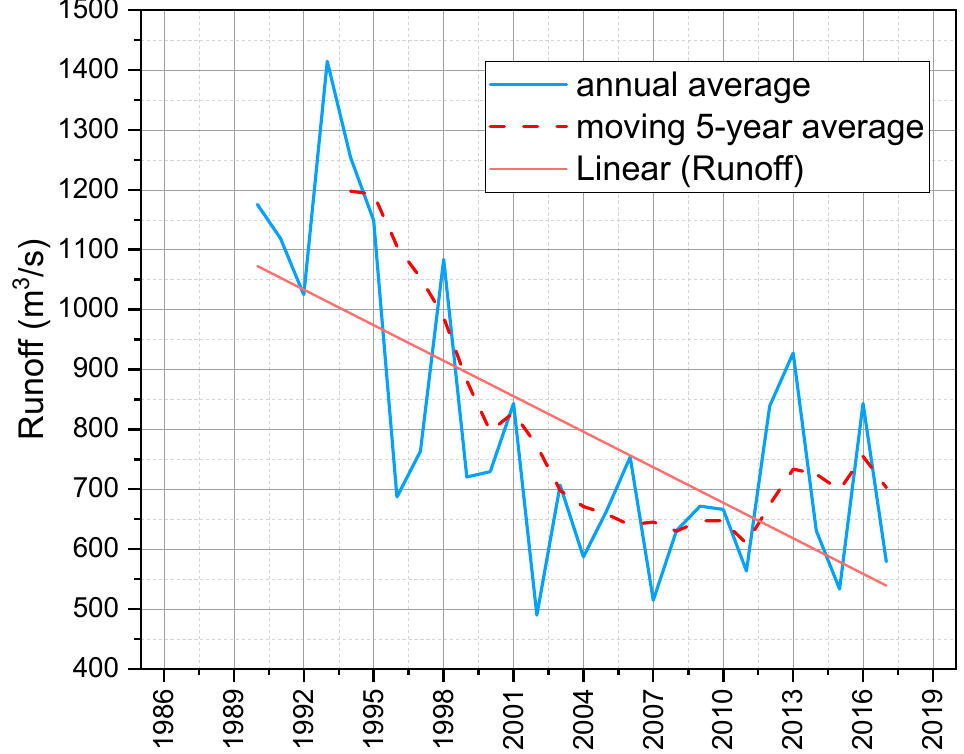
Figure 7. Runoff trend at the Mostovoi station for the period 1990–2017.